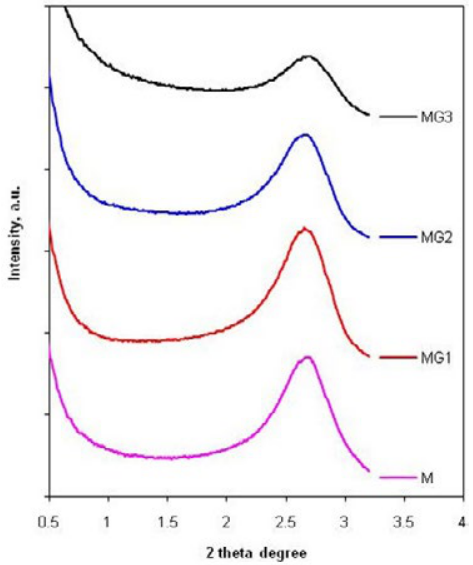
Figure 1. SAXS profiles of the pure (M) and amino-functionalized mesoporous silica MG x